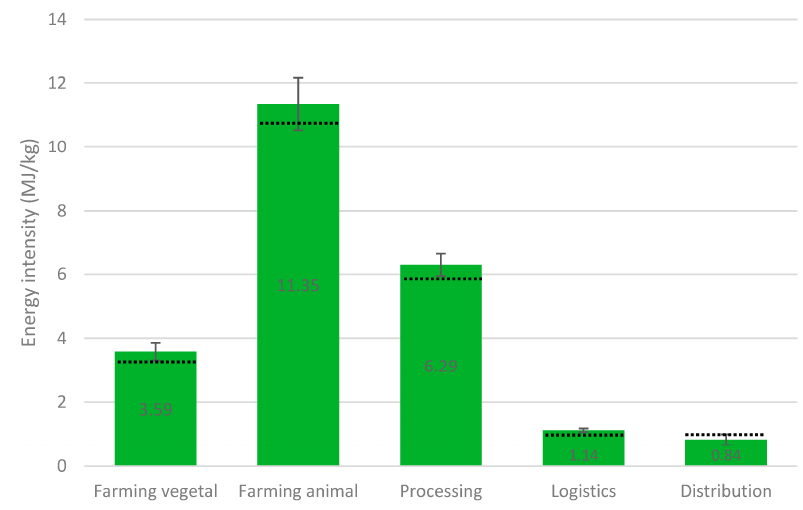
Figure 3. Average energy intensity for the different steps of the food chain, 2000–2011 (green bars), standard deviation (error bars) and energy intensity for the year 2011 (dotted lines).